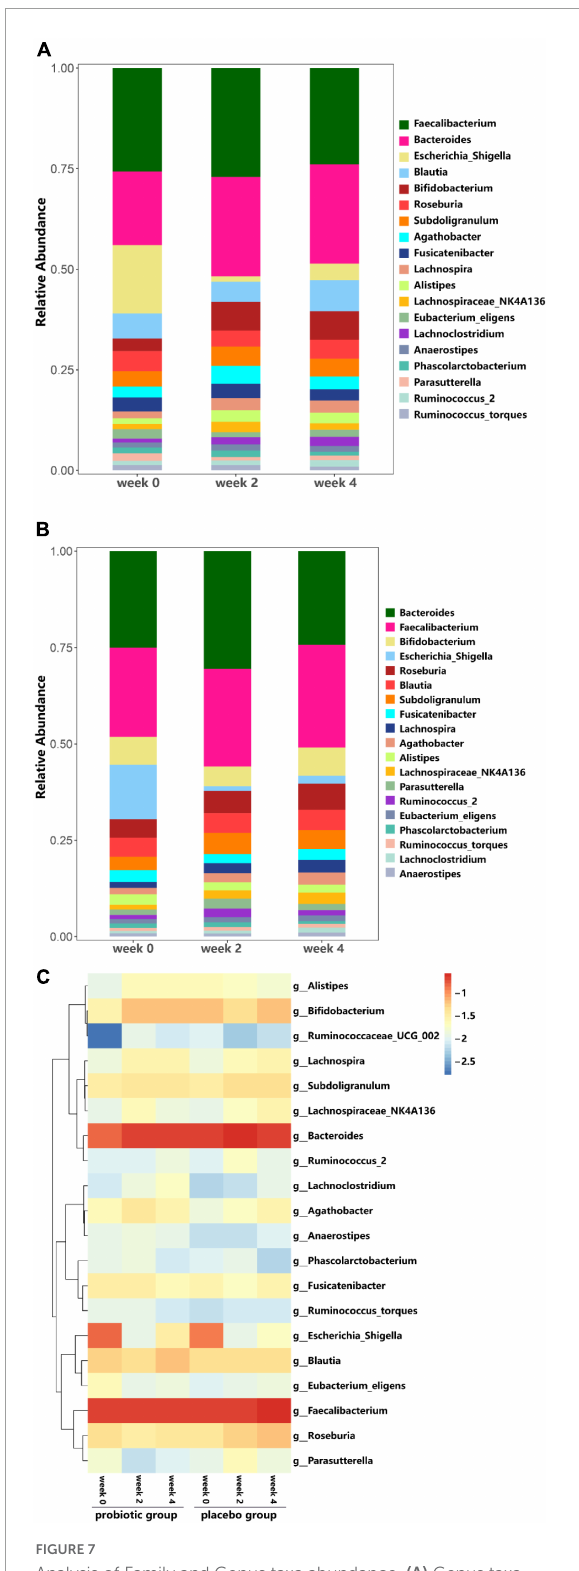
FIGURE7 Analysis of Family and Genus taxa abundance. (A) Genus taxa abundance in the probiotic group. (B) Genus taxa abundance in the placebo group. (C) Heat map of top 20